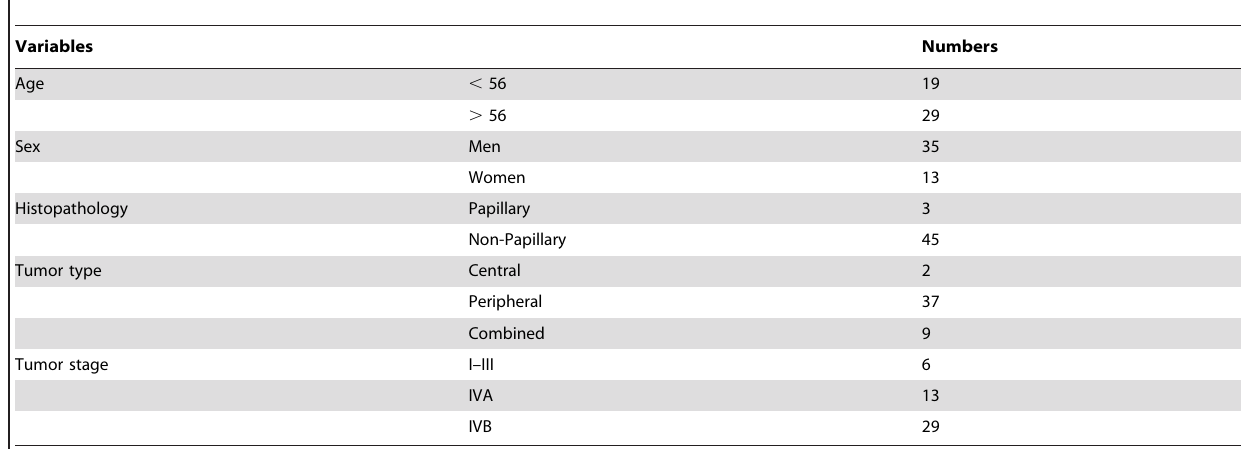
Table 1. Characteristics of CCA Patients (n =